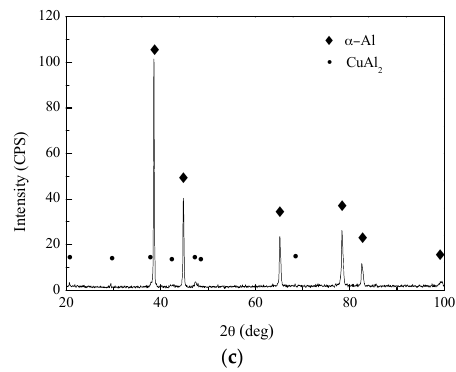
Figure 5. XRD patterns of ( a ) base metal; ( b ) weld metal of laser welding; and ( c ) weld metal of PCALW.